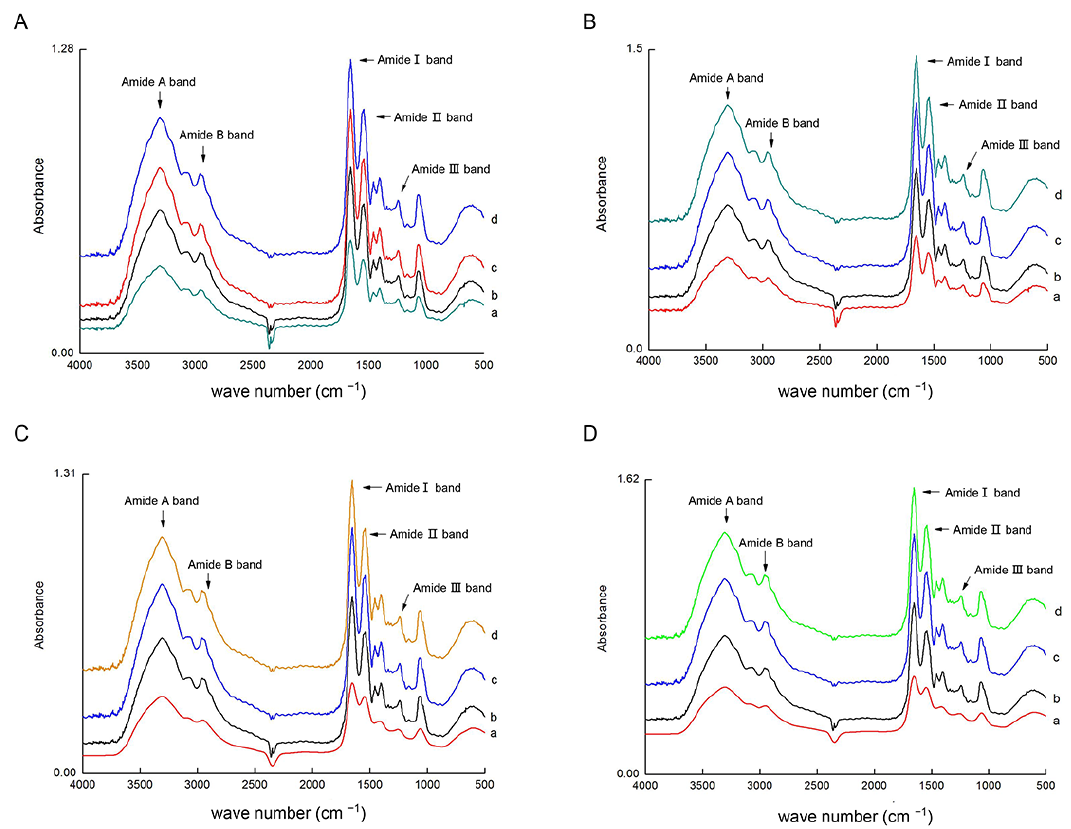
Figure 4. FTIR spectra of type I and III collagen from the semitendinosus (SD) and longissimus dorsi (LD) muscles at different growth stages. ( A , B ) represent type I collagen from the SD and LD; ( C , D ) represent type III collagen from the SD and LD; and a, b, c, and d represent 6, 9, 12, and 18 months of age, respectively.